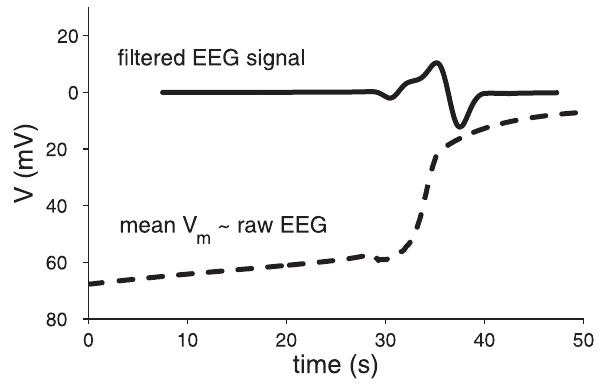
Figure 3. Mean membrane potential and simulated EEG signal. Shown are (dashed line) the simulated membrane potential averaged over 300 ms and in (solid line, a.u.) the signal that results after applying a high-pass filter ( 2 nd order Butterworth filter, cut-off at 0.1